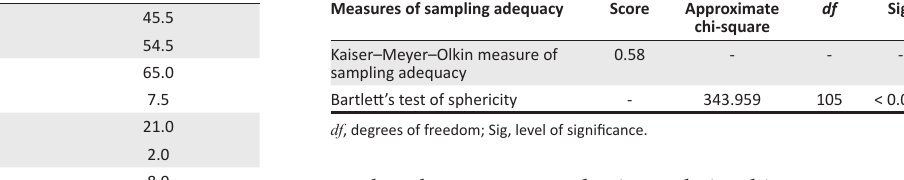
TABLE 3: Kaiser–Meyer–Olkin measure of sampling adequacy and Bartlett’s test of sphericity. Measures of sampling adequacy